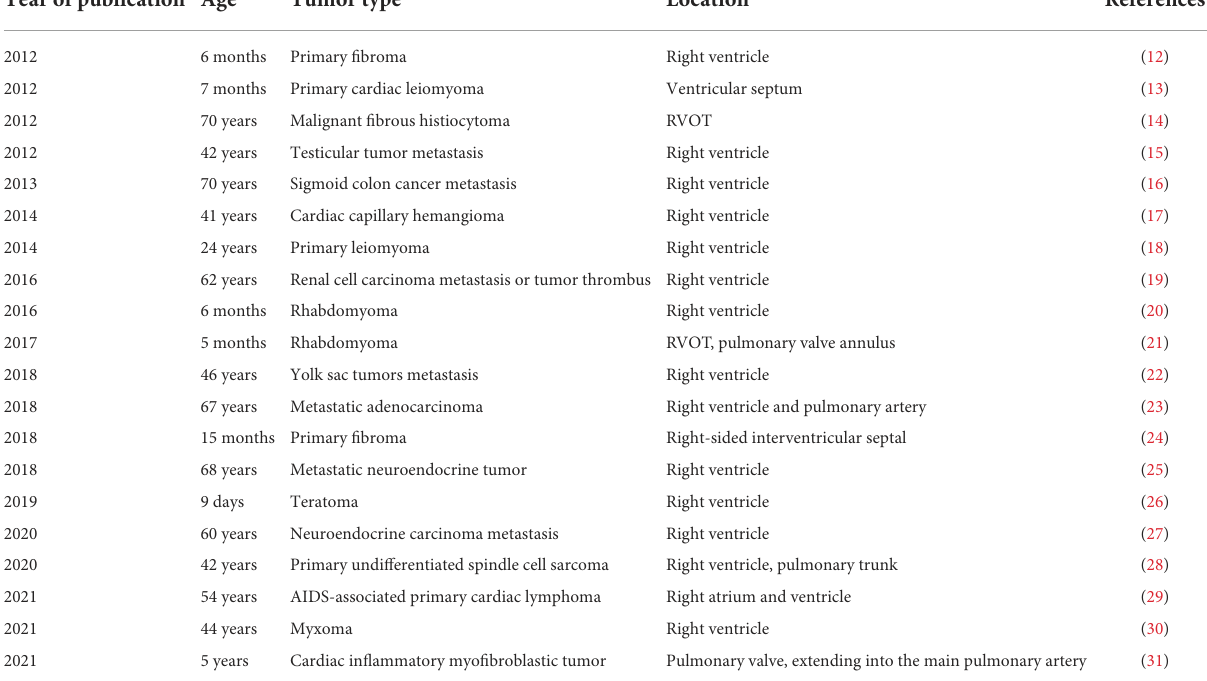
TABLE 1 Cases of RVOTO due to cardiac tumors reported in the past